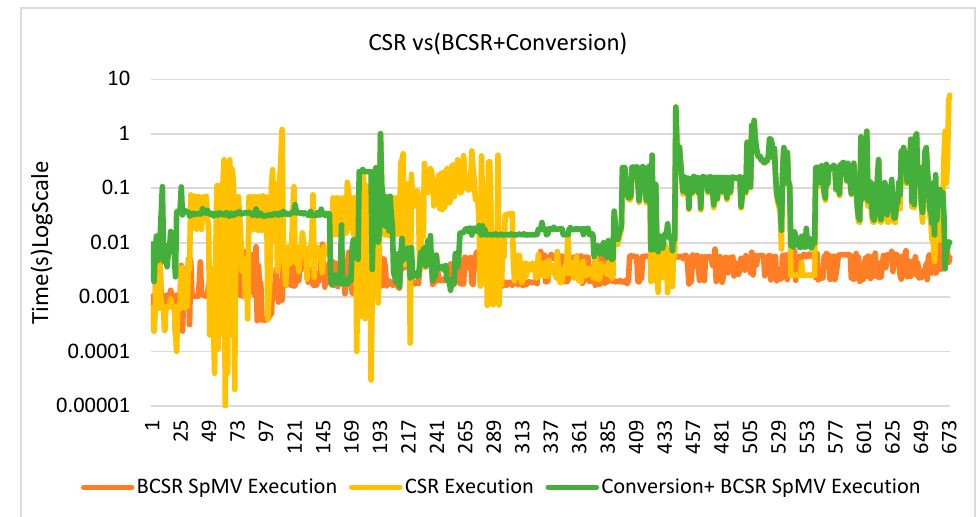
13 of 27 Figure 5. Execution time comparison of SpMV computation (dataset sorted by row-min to max).